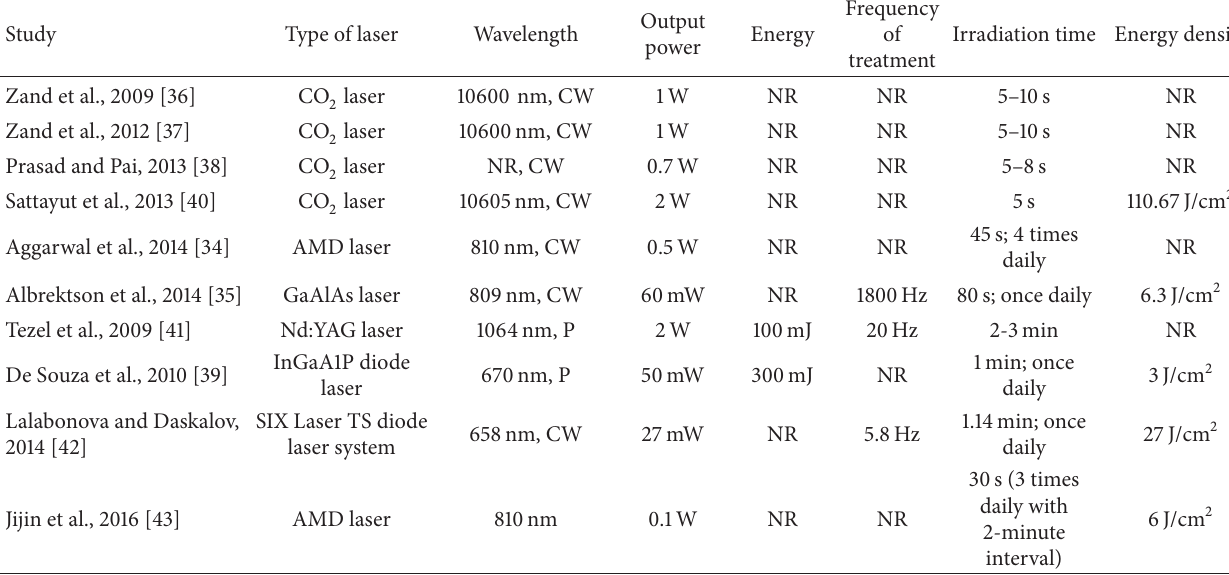
Table 5: Parameters of various types of